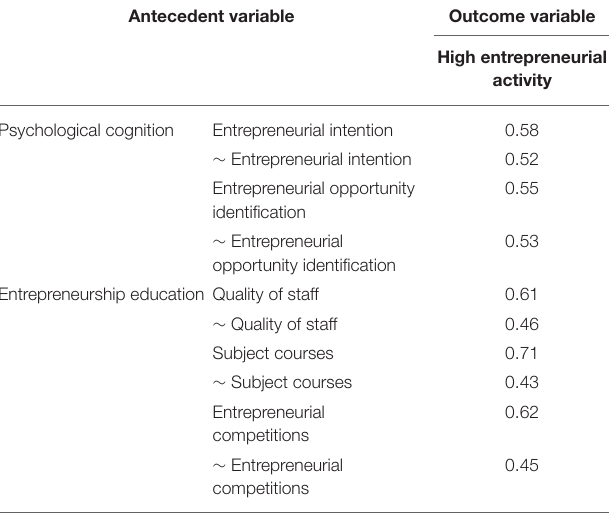
TABLE 4 | Necessity testing of entrepreneurial